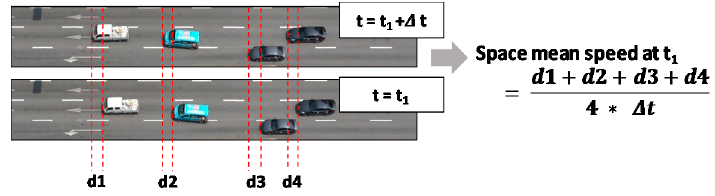
Figure 1. Conceptual explanation of space mean speed.